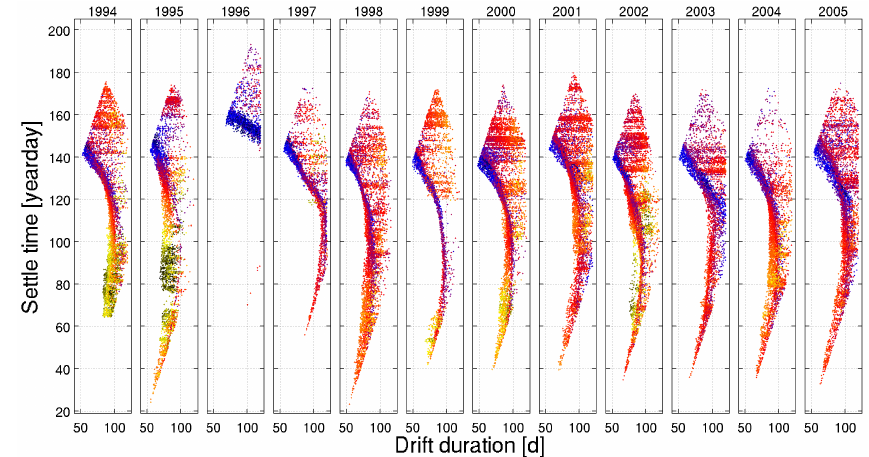
Figure 16. Drift duration and settle time of particle settling in the western Wadden Sea for the period 1994–2005. Colour of the dots represents again the distance from the settle location, and is the same as in Fig.